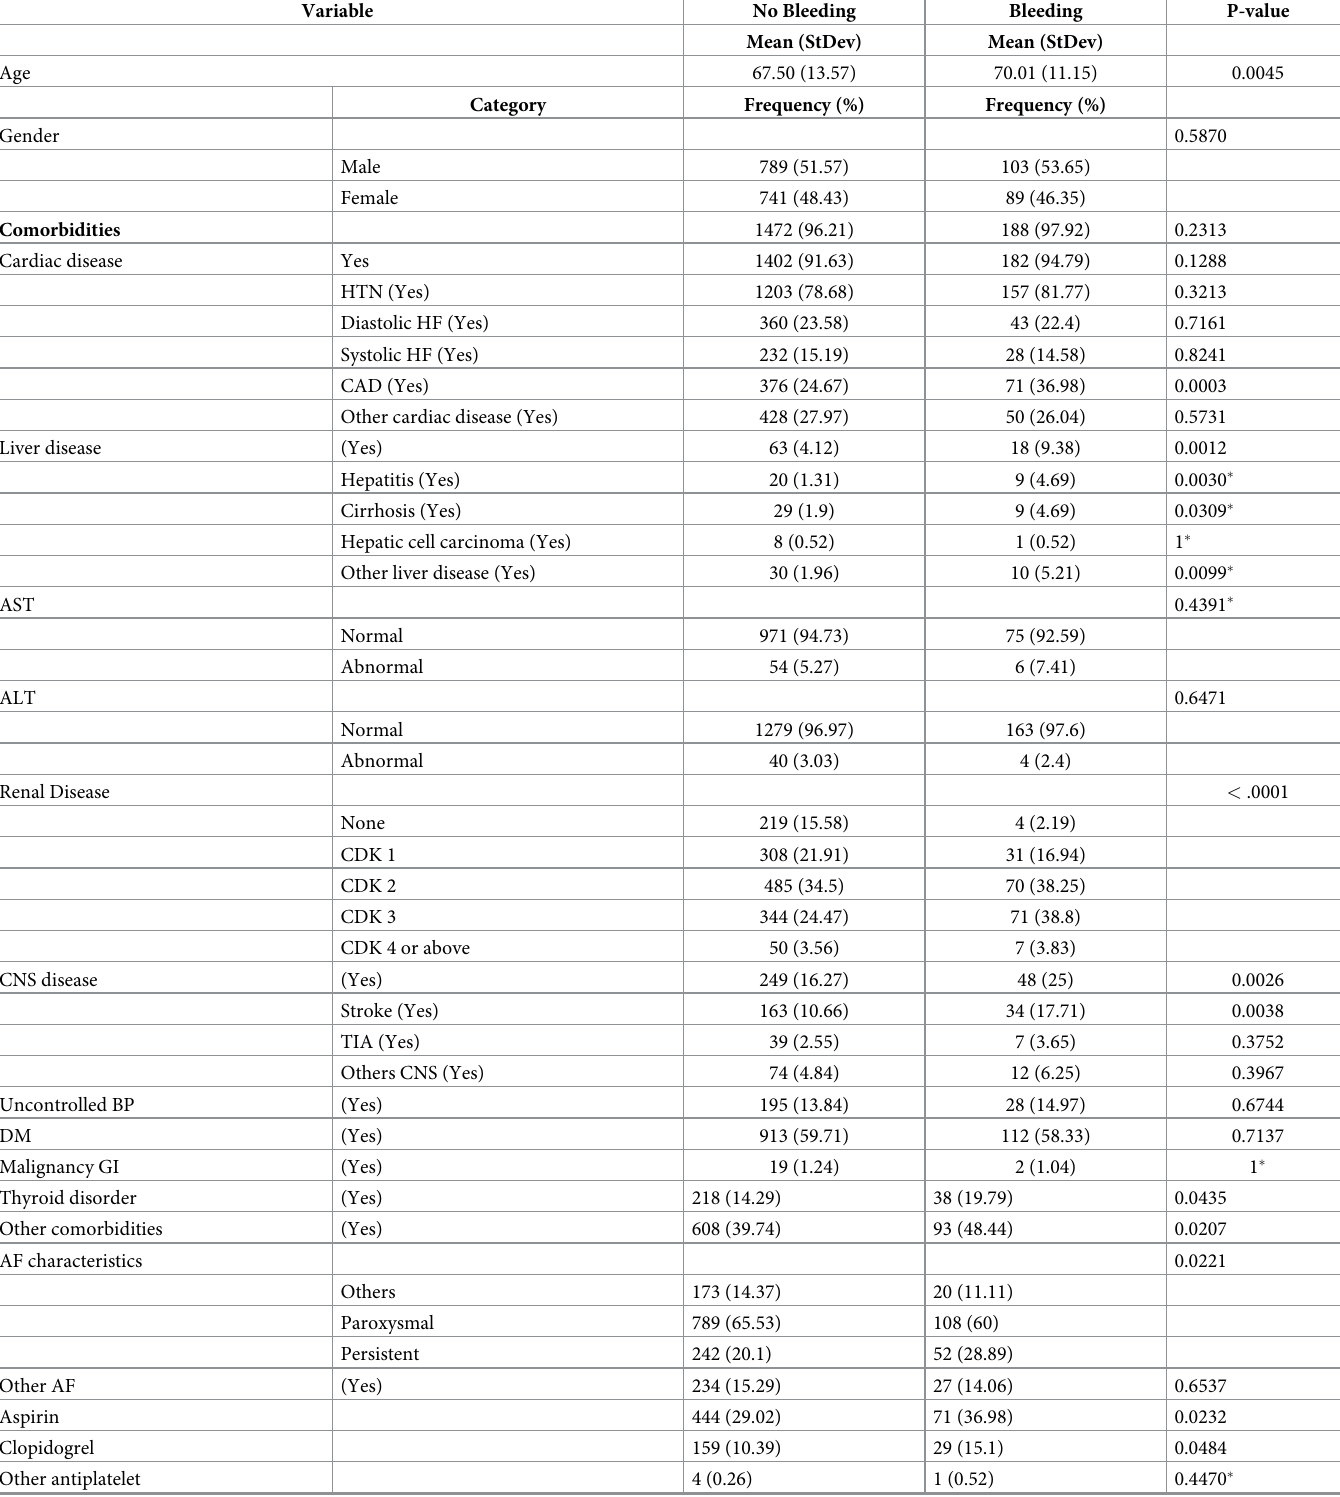
Table 2. Proportions of bleeding and non-bleeding events distributed by